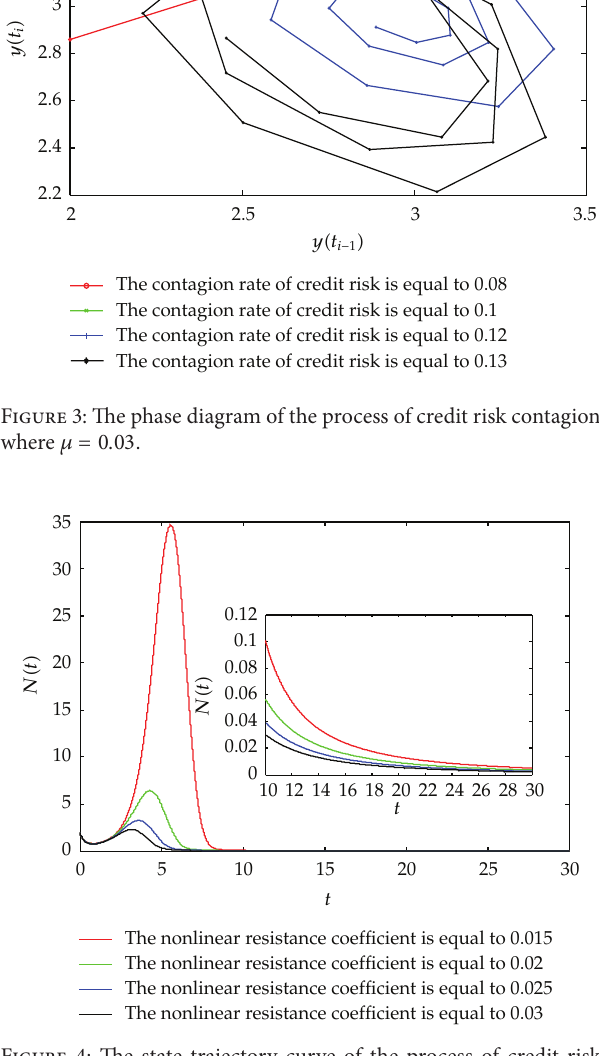
Figure 4: The state trajectory curve of the process of credit risk contagion where 𝜆 = 0.1